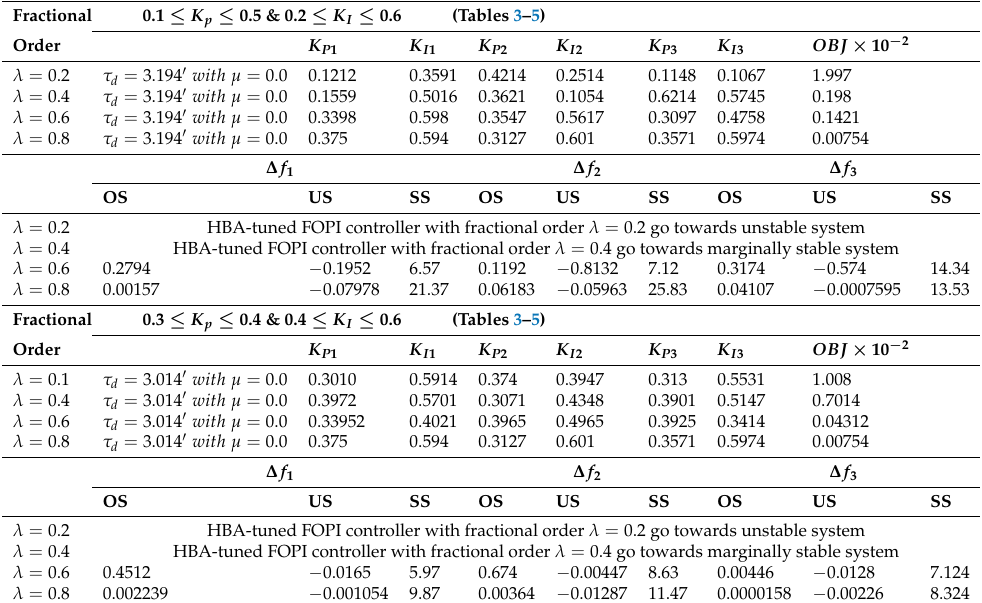
Table 8. Gain values of FOPI controllers for thermal − solar − wind system (test system 2) with DGS under deregulated environment in bilateral condition with time delays.